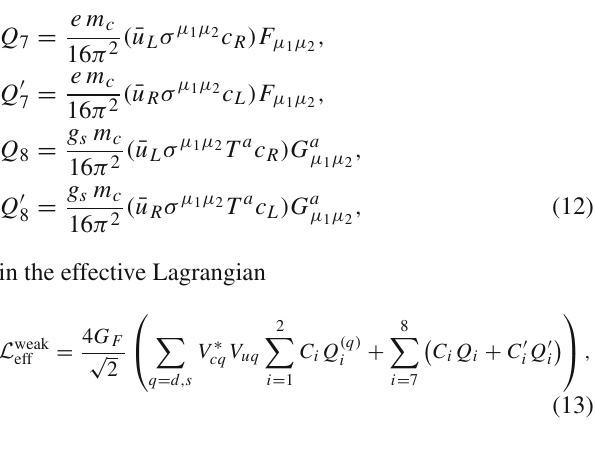
Fig. 1 Weak annihilation (left) and short-distance (right) diagrams for D → V γ decays. There are additional diagrams (not shown) induced by Q 1 , 2 where the photon is emitted from other quark lines While this holds model-independently for V = final state mesons ρ 0 , ω and, to a lesser degree, the φ allow for additional contributions in and beyond the SM. Here we consider BSM effects in dipole